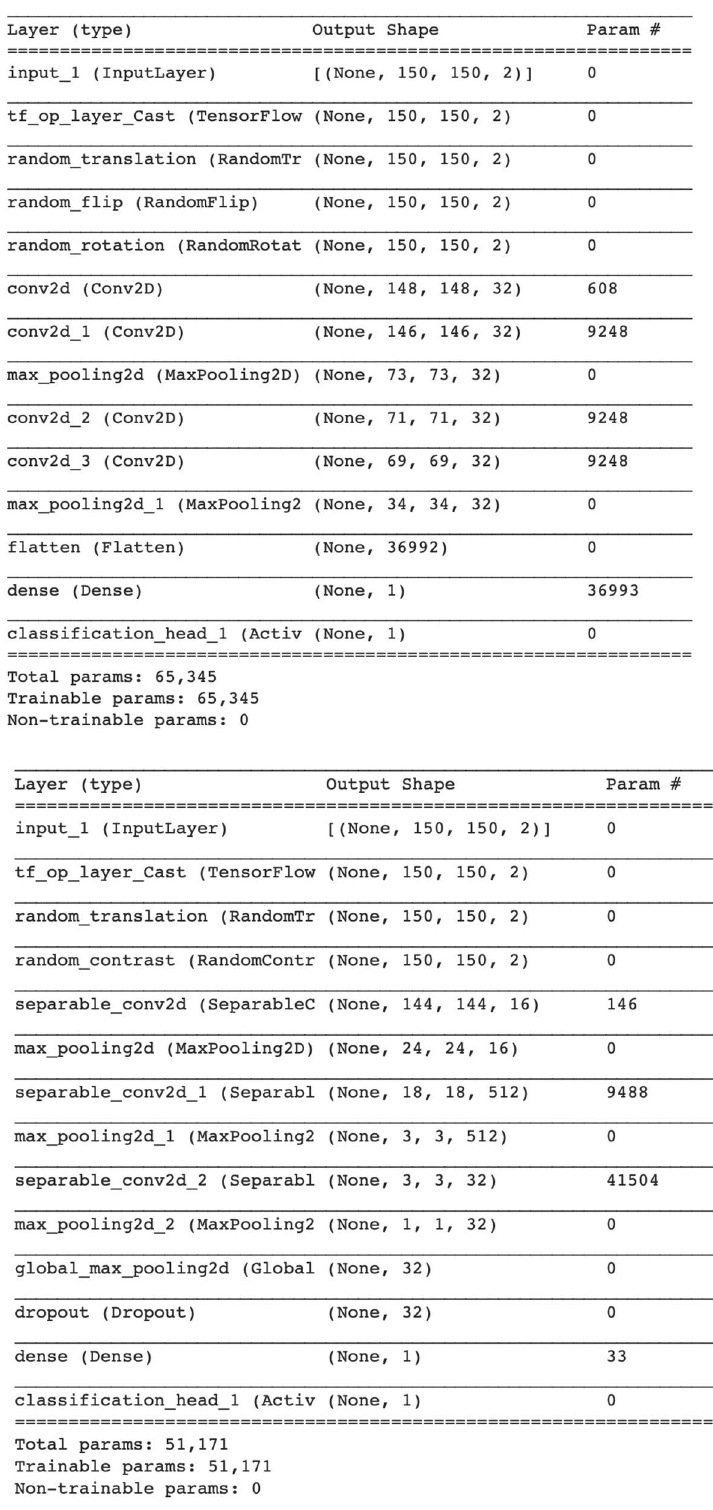
Figure 5. Customized models with layer type, output shape and number of parameters for each layer to detect lesions in PZ (Upper) and CG (Lower),